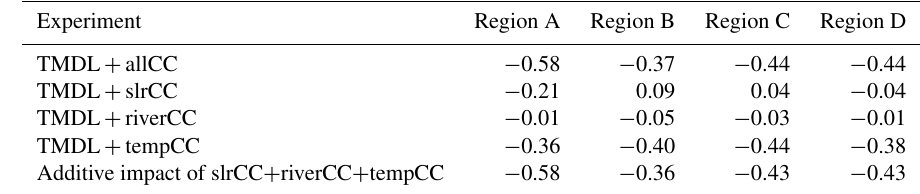
Table 4. Average (1993–1995) change in cumulative hypoxic volume (km 3 days) for various oxygen concentration ranges, relative to the TMDL + noCC experiment.